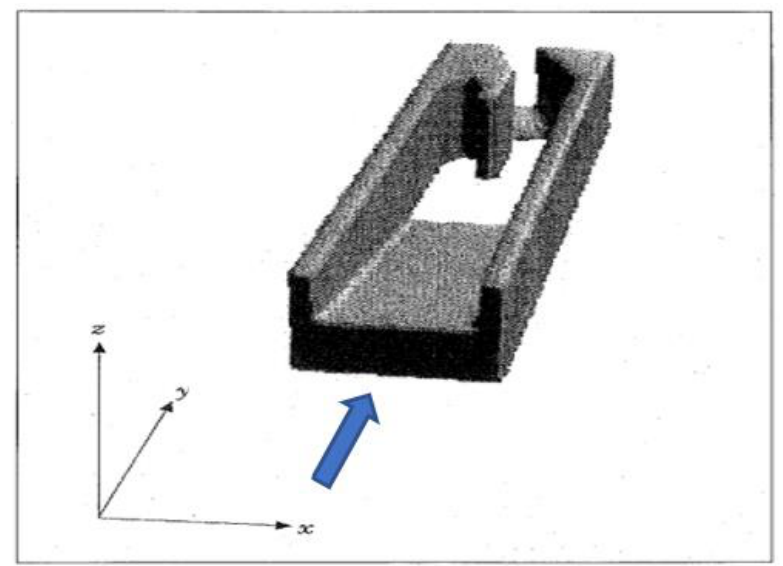
Figure 15. Drainage structure passing through the base of the West Wall, accepting drainage water from the Figure 14 channel. The arrow denotes the water flow direction. From [1], p. 341; FLOW-3D CFD model by author.